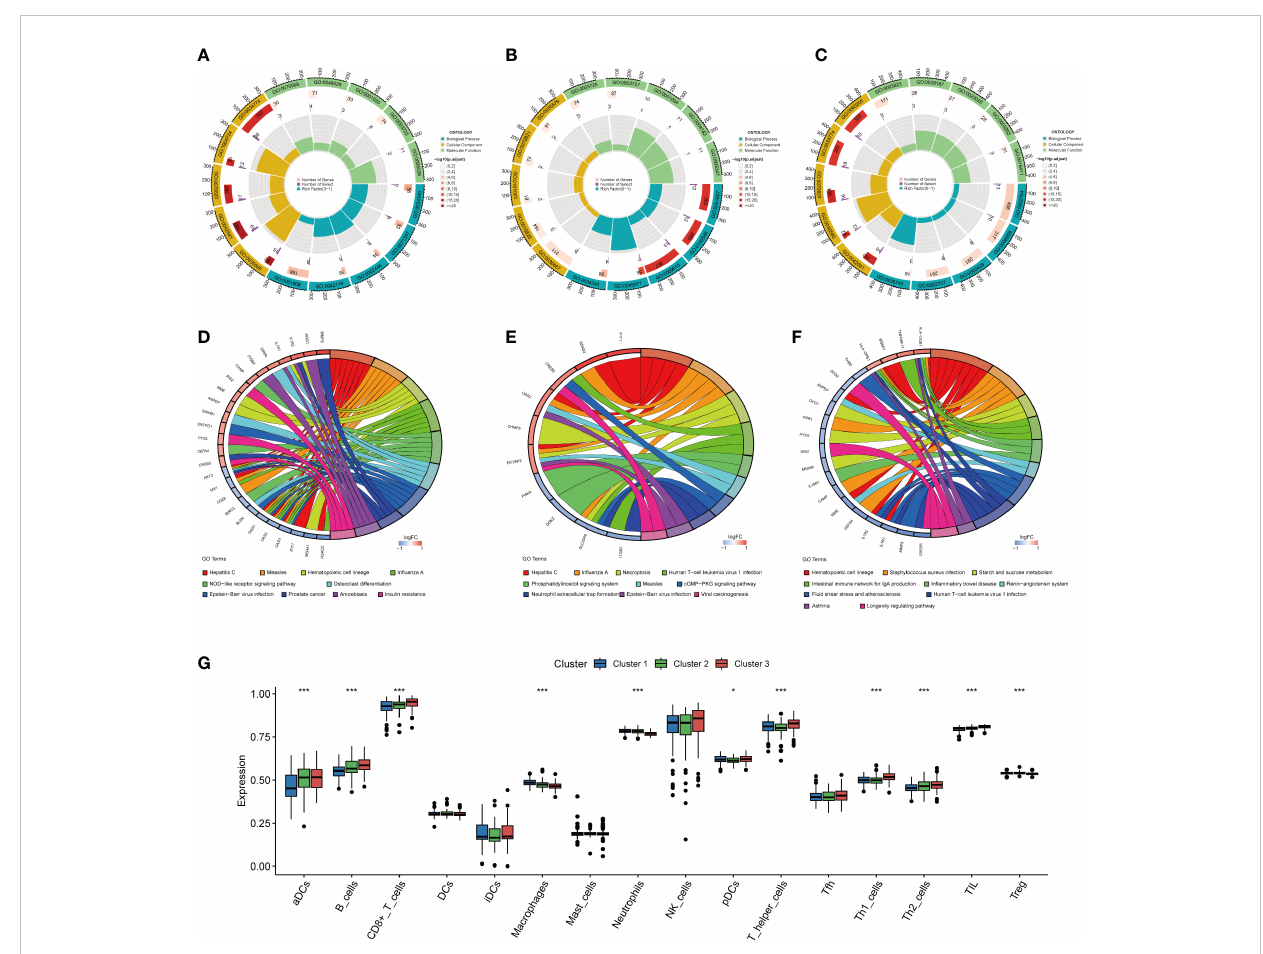
FIGURE 9 Functional enrichment and immune cell in fi ltration analyses among three NETs subgroups. (A – C) . GO enrichment analysis of DEGs highly expressed in cluster 1 (A) , cluster 2 (B) , and cluster 3 (C) . (D – F) . KEGG enrichment analysis of DEGs highly expressed in cluster 1 (D) , in cluster 2 (E) , and in cluster 3 (F) . (G) Box plot showing the relative abundances of immune cells among three clusters, *P < 0.05, ***P < 0.001. NETs, neutrophil extracellular traps; GO, gene ontology; KEGG, Kyoto encyclopedia of genes and